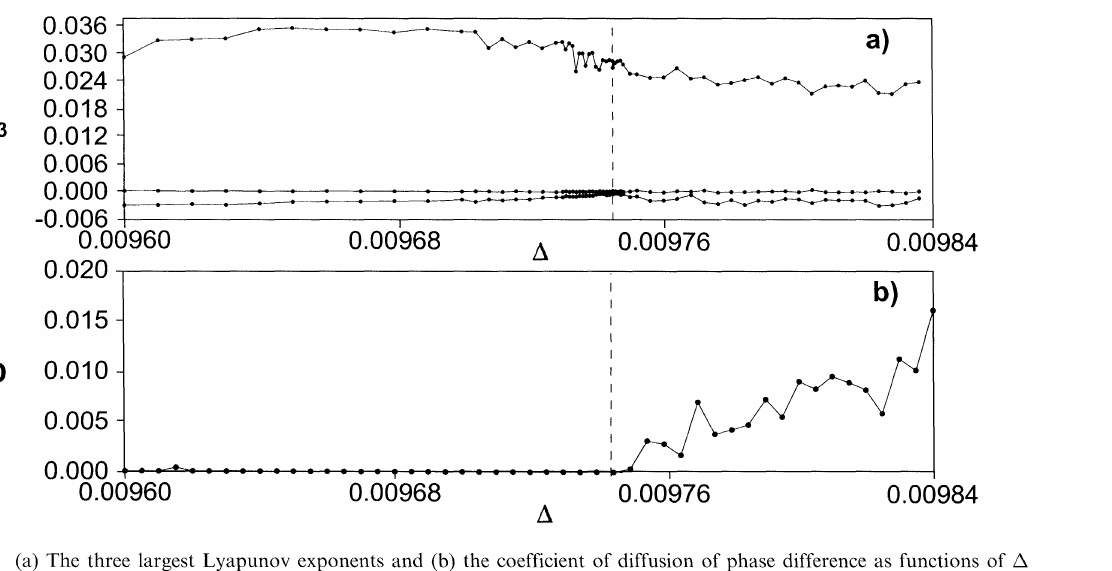
FIGURE 8 (a) The three largest Lyapunov exponents and (b) the coefficient of diffusion of phase difference as functions of A at # 6.8 (direction a in Fig.